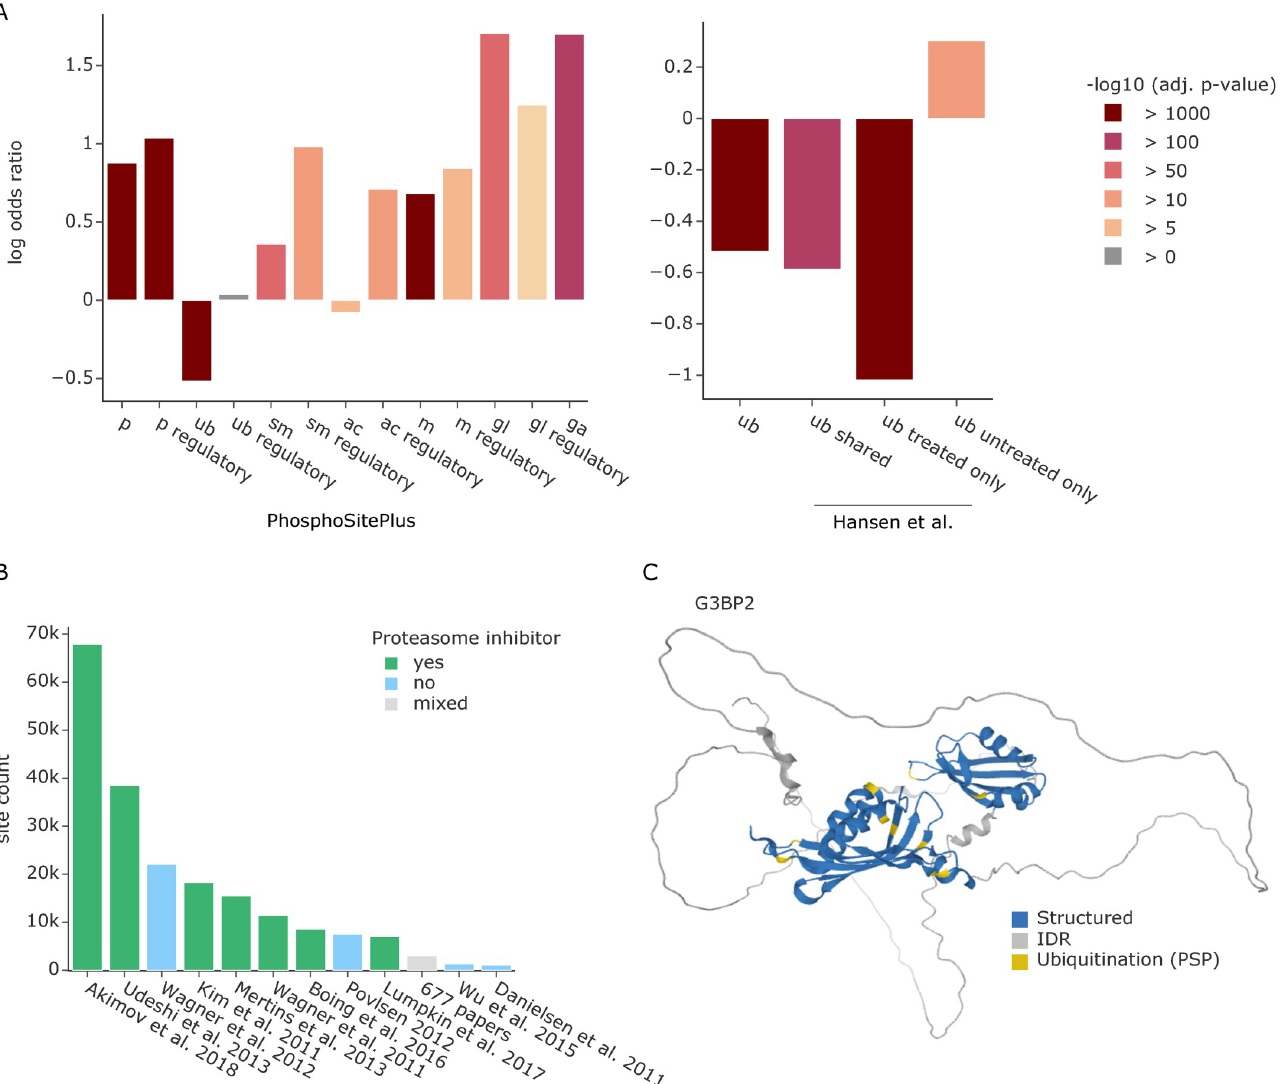
Fig 2. Enrichment analysis of PTMs in IDRs. (A) Enrichment of different PTMs annotated in the PhosphoSitePlus database in IDRs (left). Enrichment of ubiquitinated lysines annotated in PhosphoSitePlus versus ubiquitinations detected in a dataset treated with proteasome inhibitor or untreated (right) [4]. PTMs are abbreviated as follows: phosphorylations (p), ubiquitinations (ub), sumoylations (sm), acetylations (ac), methylations (m), and the glycosylations O-GlcNAc (gl) and O-GalNAc (ga). Source data are available at Github . (B) Overview of datasets that contribute ubiquitination sites to PhosphoSitePlus. Publications reporting > 1,000 ubiquitination sites are listed separately and are colored based on their use of proteasome inhibitors. The additional 677 studies that contribute fewer ubiquitination sites were aggregated to a gray bar irrespective of their use of proteasome inhibitors. Source data are available at Github . (C) AlphaFold predicted structure of Ras GTPase-activating protein-binding protein 2 (G3BP2) colored by structured regions (blue) and predicted IDRs (gray) as well as ubiquitination sites annotated in PhosphoSitePlus (yellow). IDR, intrinsically disordered region; PTM, posttranslational modification.